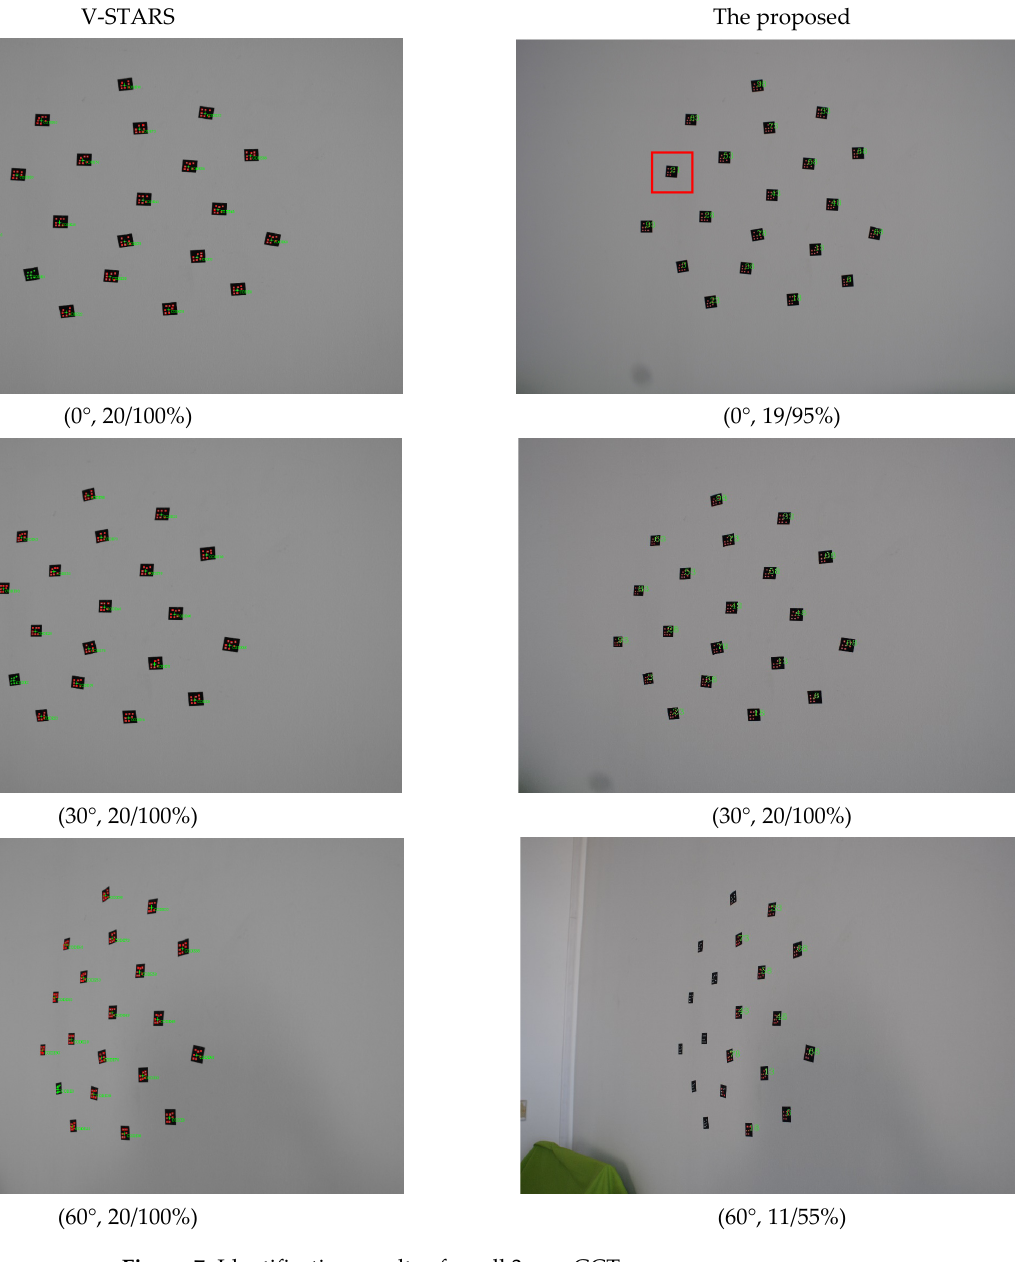
Figure 7. Identification results of small 3 mm GCTs.